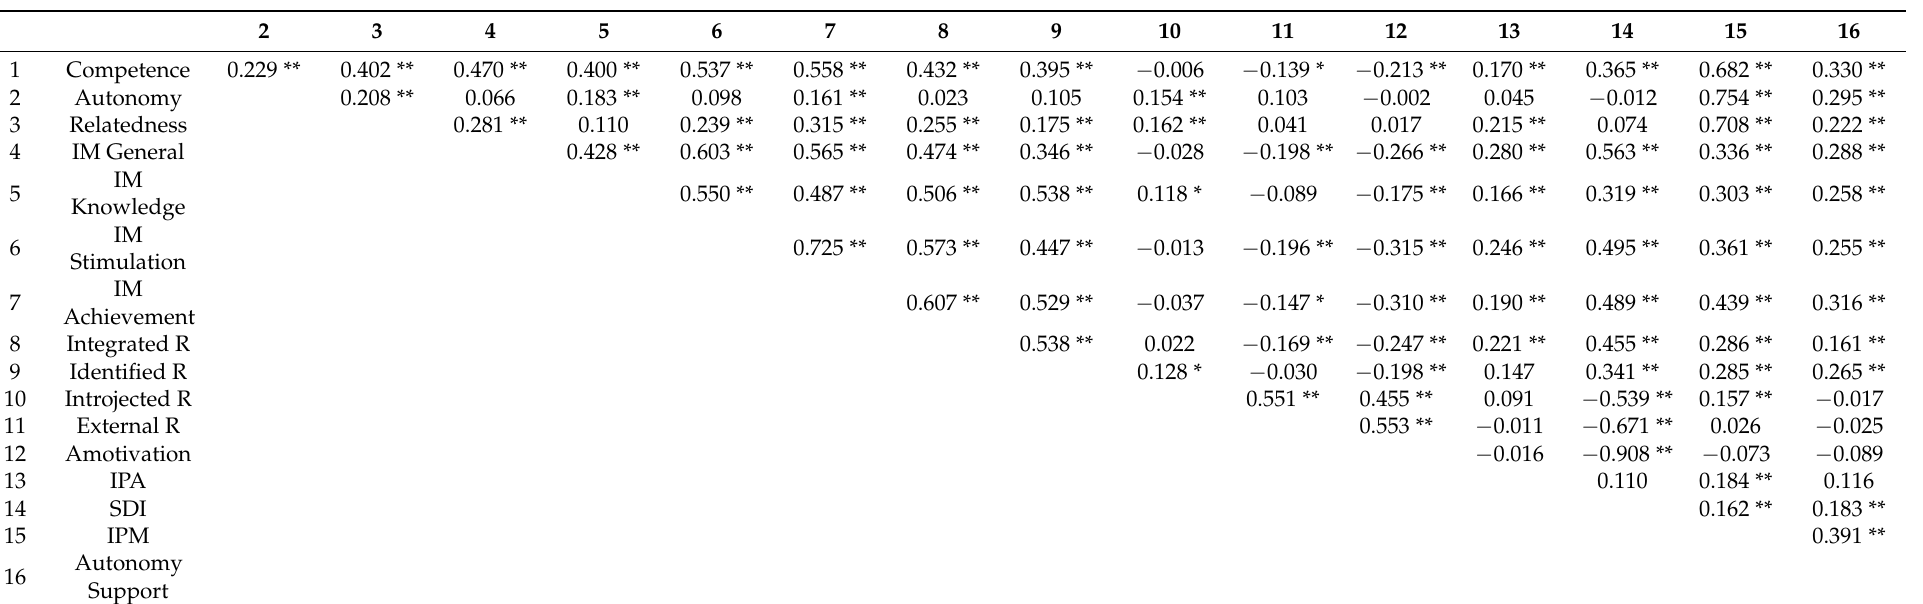
Table 2. Correlation